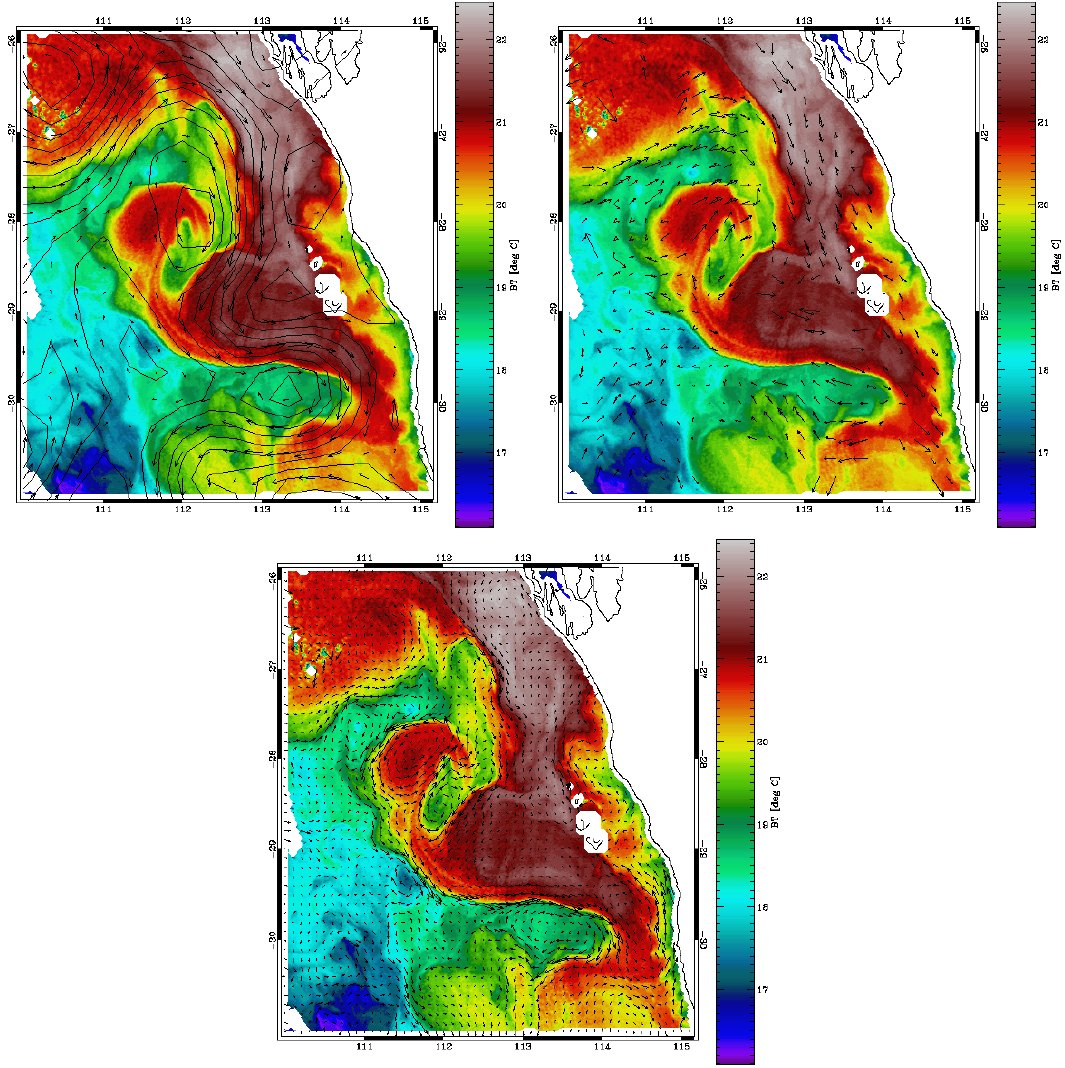
Figure 6. Sea surface temperature from AVHRR. Upper left: absolute dynamic topography from AVISO (black lines) and the associated geostrophic velocities (arrows). Top right: velocities derived from a sequence of thermal images using the MCC method (arrows). Bottom: velocities derived from the thermal image using a Butterworth filter